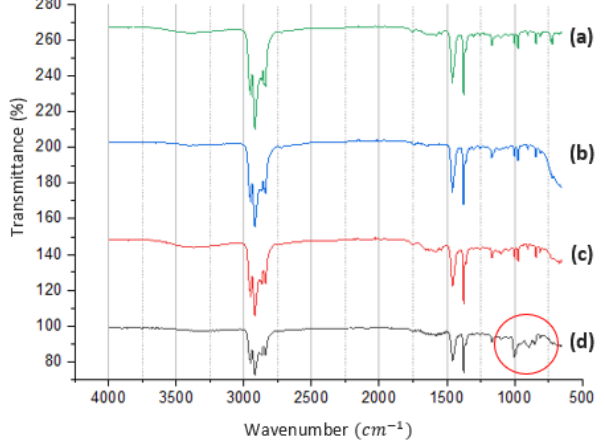
Figure 6. FTIR ATR spectra of ( a ) PP. ( b ) Food packaging plastic. ( c ) rPP; ( d ) rPP + 10%.